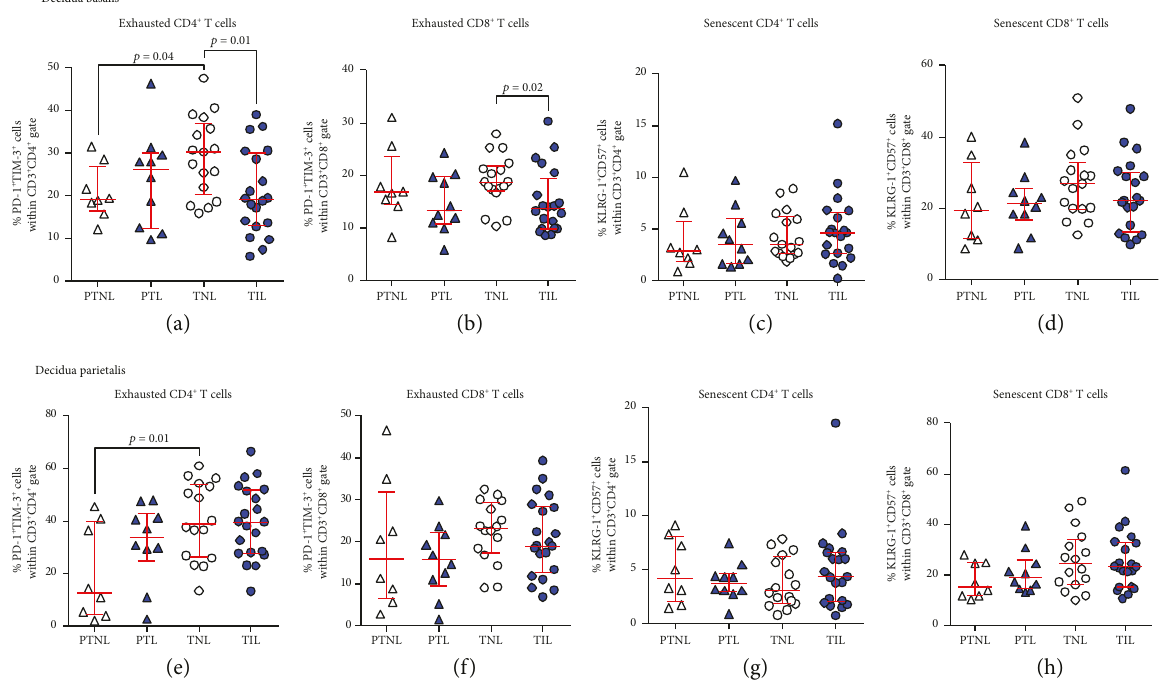
Figure 4: Proportions of exhausted and senescent CD4 + and CD8 + T cells in the decidua basalis and decidua parietalis. The proportions of exhausted and senescent CD4 + and CD8 + T cells in the decidua basalis (a – d) and decidua parietalis (e – h) from women who delivered preterm with labor (PTL) or without labor (PTNL) and women who delivered at term with labor (TIL) or without labor (TNL). N = 8 – 21 per group. Red midlines and whiskers indicate medians and interquartile ranges,